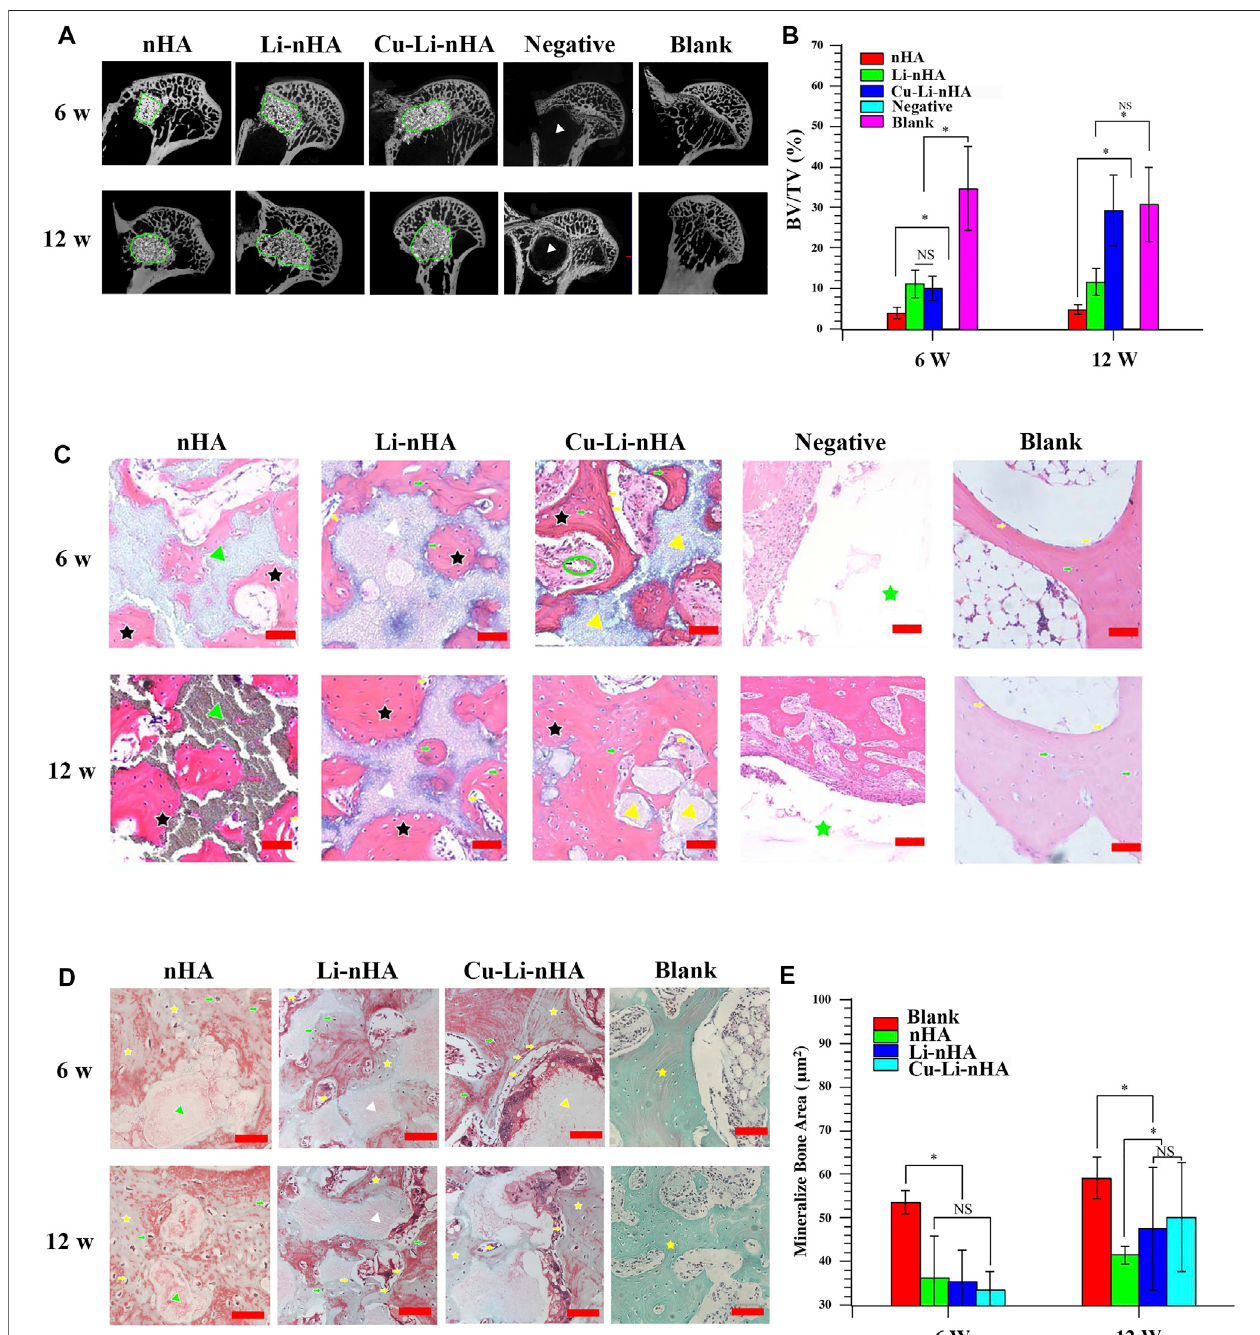
FIGURE 7 | (A,B) Micro-CT observation and BV/TV values in the bone defect area. The regions within the green circle were implanted with scaffolds. Materials showed high density and new trabecular bone showed medium density. Negative Group: only drilling tunnels. Blank Group: without ONFH modeling and scaffold- implantation operation. White triangle: region of drilling. (C) HE staining. Black asterisk: trabecular bone. Green asterisk: drilling region. Yellow arrow: lining cell. Green arrow: osteocyte. Green triangle: nHA scaffold. White triangle: Li-nHA scaffold. Yellow triangle: Cu-Li-nHA scaffold. Green circle: neovascularization. Negative Group: only drilling tunnels. Blank Group: without ONFH modeling and scaffold-implantation operation. Scale bar in the bottom right-hand corner of each image (red): 100 μ m. (D,E) Goldnerstainingandmineralizeboneareaanalysis.Mineralizedbonewasstainedingreen,andosteoidwasinred.Yellowasterisk:mineralizedtrabecular bone. Yellow arrow: lining cell. Green arrow: osteocyte. Green triangle: nHA scaffold. White triangle: Li-nHA scaffold. Yellow triangle: Cu-Li-nHA scaffold. Blank Group: without ONFH modeling and scaffold-implantation operation. Scale bar in the bottom right-hand corner of each image (red): 50 μ m. Statistical analysis was conducted using a one-way analysis of variance with post-hoc Bonferroni ’ s multiple comparisons test. NS: p > 0.05, * p < 0.05.